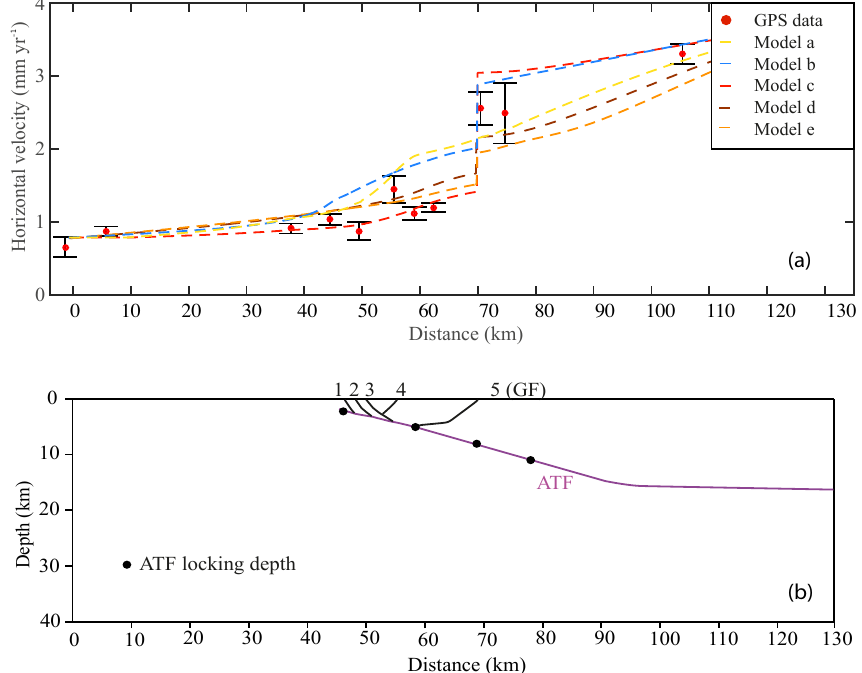
Figure 4. Horizontal velocity trend for different models obtained after the scouting of the ATF locking depth effects and creeping simulated on different synthetic and antithetic faults (see Sect. 4 for details). In the ATFa model, we considered an ATF locking depth of 5km, whereas the other faults are locked. In the ATFb and ATFc models we considered an ATF locking depth of 2 and 5km respectively, and only the Gubbio fault is creeping. Finally, in the ATFd and ATFe models, we considered an ATF locking depth of 8 and 11km respectively, and all the other faults are creeping. We calculate the weighted root mean squares (WRMS) in order to compare the results obtained from the numerical simulations with the GPS velocity observed: WRMS Model a = 0 . 30; WRMS Model b = 0 . 37; WRMS Model c = 0 . 19; WRMS Model d = 0 . 21; WRMS Model e = 0 . 23. The best fit is obtained for Model